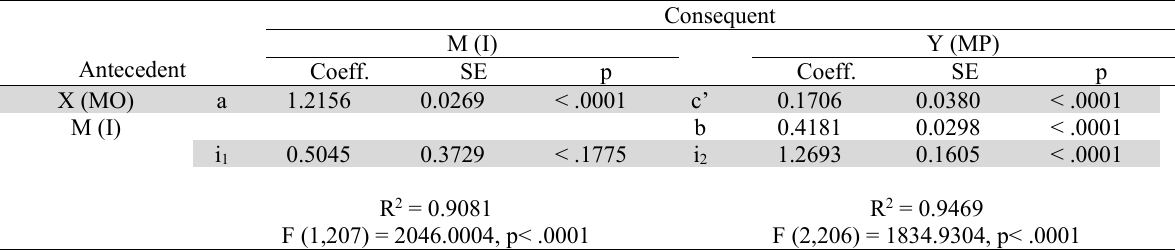
Summary of research analysis